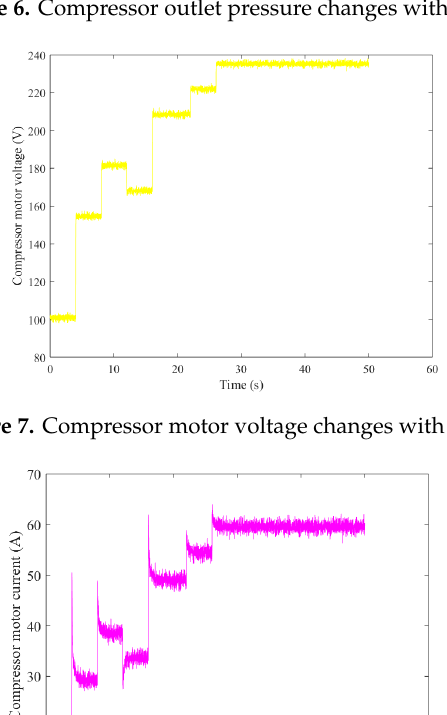
Figure 9. Hydrogen inlet pressure changes with time. Figure 10. Air inlet pressure changes with time. In this paper, the Gaussian noise with variance of 0.1, 0.2, 0.5, and 1.0 are added to the PEM fuel cell simulator model, respectively. The PFCM algorithm is used to filter samples with membership and typicality less than 90% and optimize the original dataset. The filtered data is used as the sample dataset. The sample dataset are divided into two groups, one is the training set sample and the other is the testing set sample. The training set sample number is 670, and the testing set sample number is 335. The penalty parameter C and kernel function parameter g of SVM are optimized using the ABC algorithm, and then establish the optimized SVM model. The testing set sample is used to test the accuracy of the fault diagnosis method. The fault diagnosis steps of the fuel cell system based on the PFCM-ABC-SVM method are as follows: